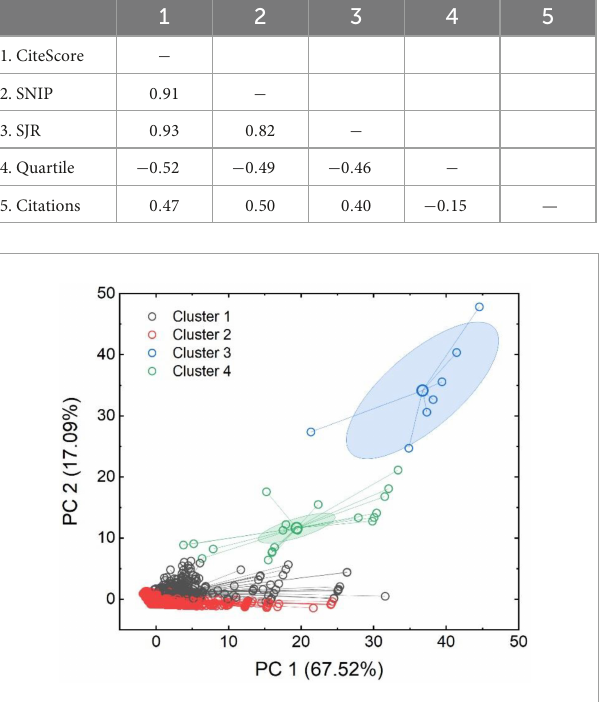
FIGURE8 Clustering of quartiles, citations, SNIP, SJR, and CiteScore of all the publications by Ecuadorian universities.